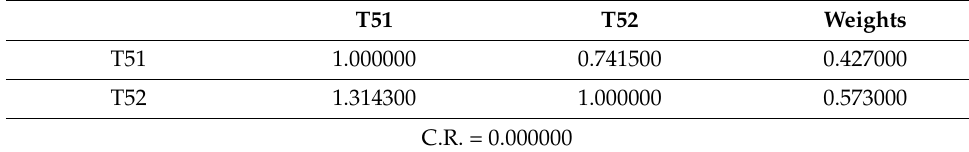
Table 12. Aggregated pair-wise comparison matrix at level 2 for Attack